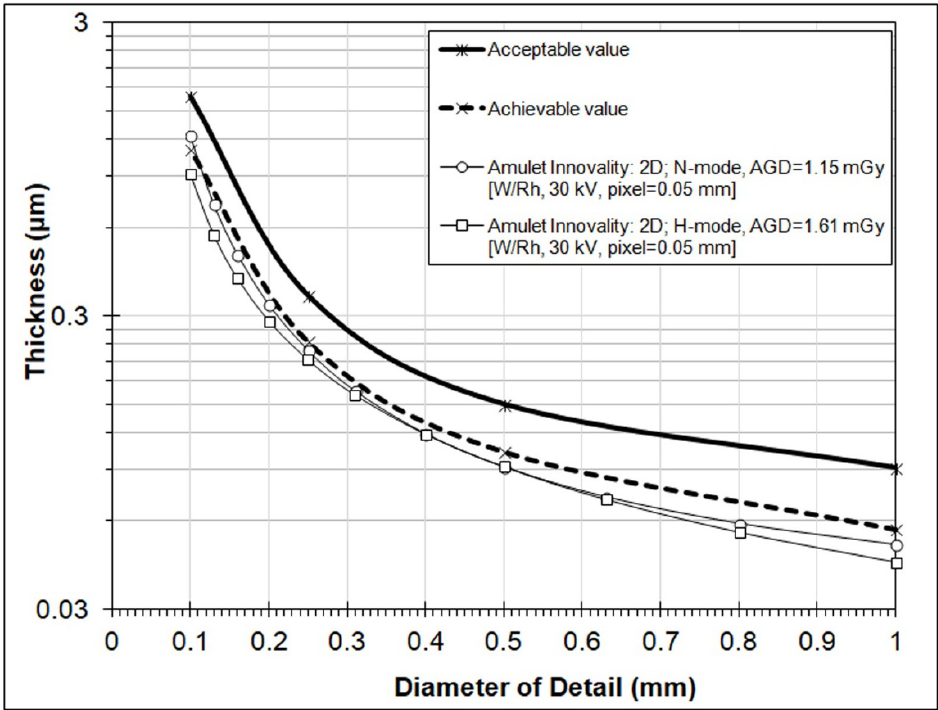
Figure 3. Contrast–detail curves for 2D images obtained using two dose levels (N-mode and H-mode). (Results from the CDMAM3.4 Analyser software.)